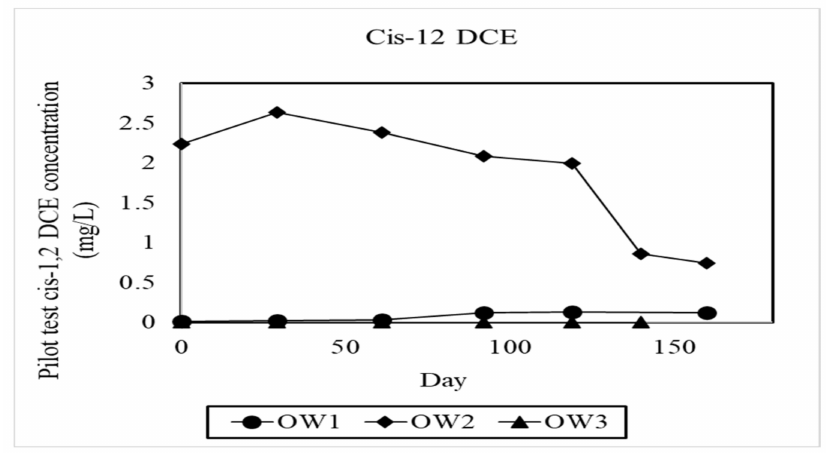
Figure 8. cis -1,2-DCE concentration variation of each monitoring well in the in situ field testing.